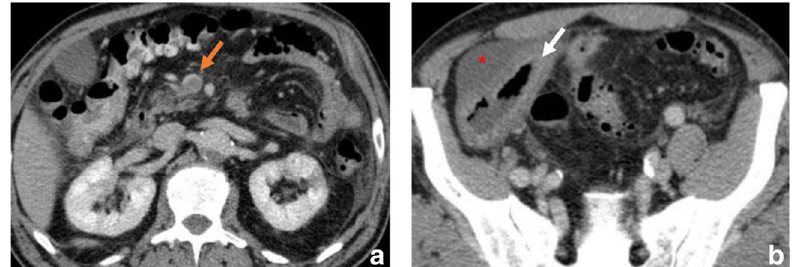
Fig. 4 Venous occlusion. Contrast-enhanced CT image of the abdomen in 49-year-old female with superior mesenteric vein thrombosis. ( a ) Contrast-enhanced axial CT scan shows a thrombus in the superior